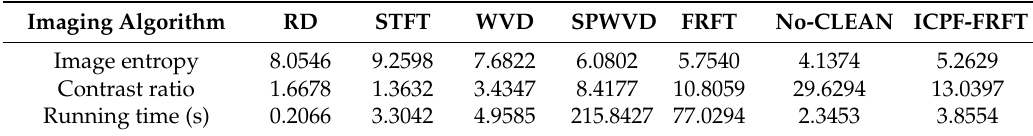
Table 2. Comparison of simulation aircraft imaging